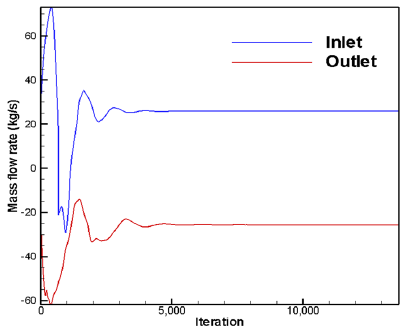
Figure 3. Time histories of mass flow rates.